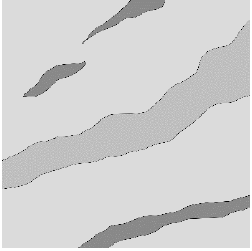
Figure 14. Reference ZX section of the stone block.